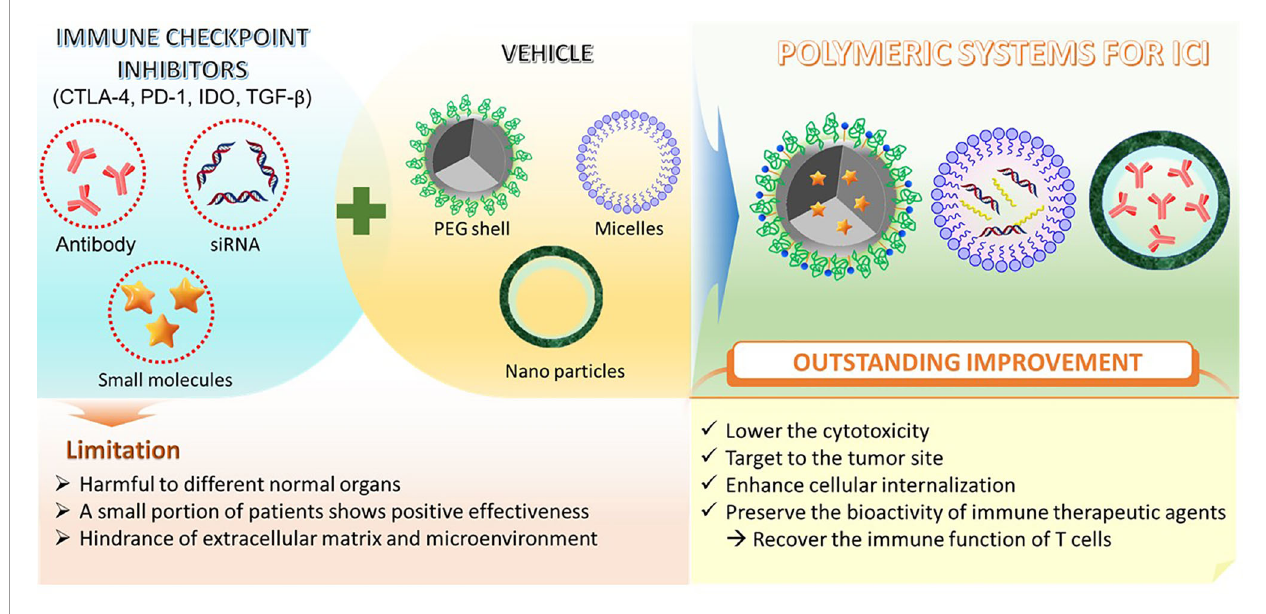
FIGURE 2 | Schematic of different polymeric systems designed for ICI